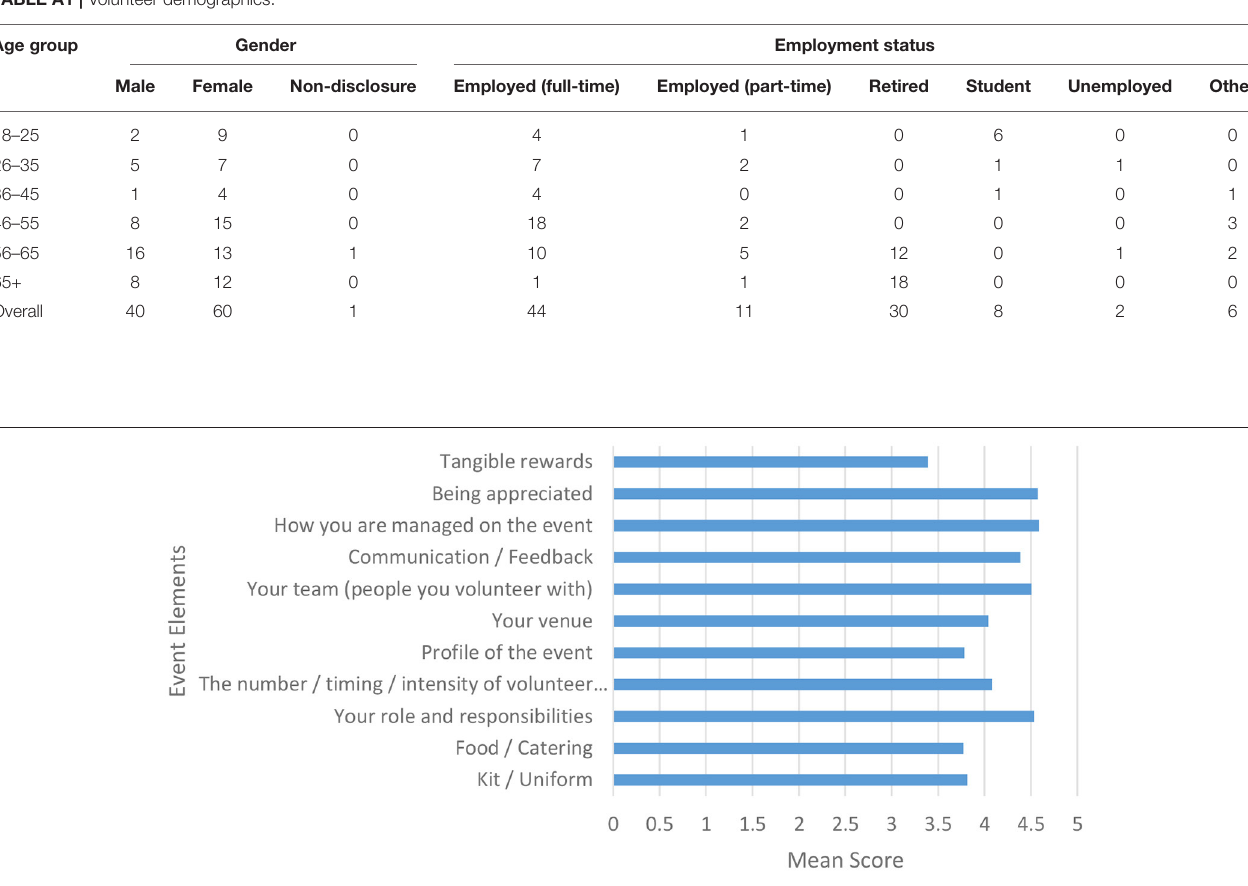
Figure A1 | Importance of volunteer experience in sport events.